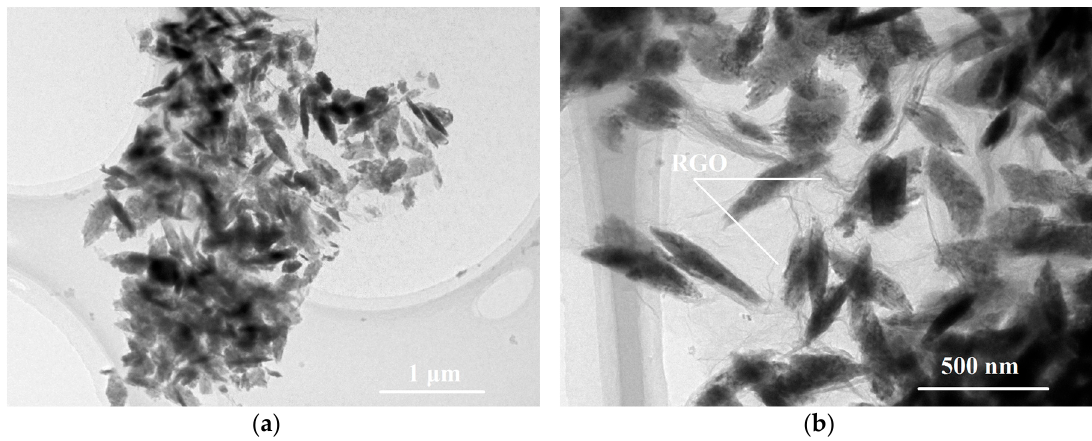
Figure 4. TEM images of the 10% ‐ RGO–CuO hybrid naocatalysts with ( a ) low magnification and ( b ) high magnification.